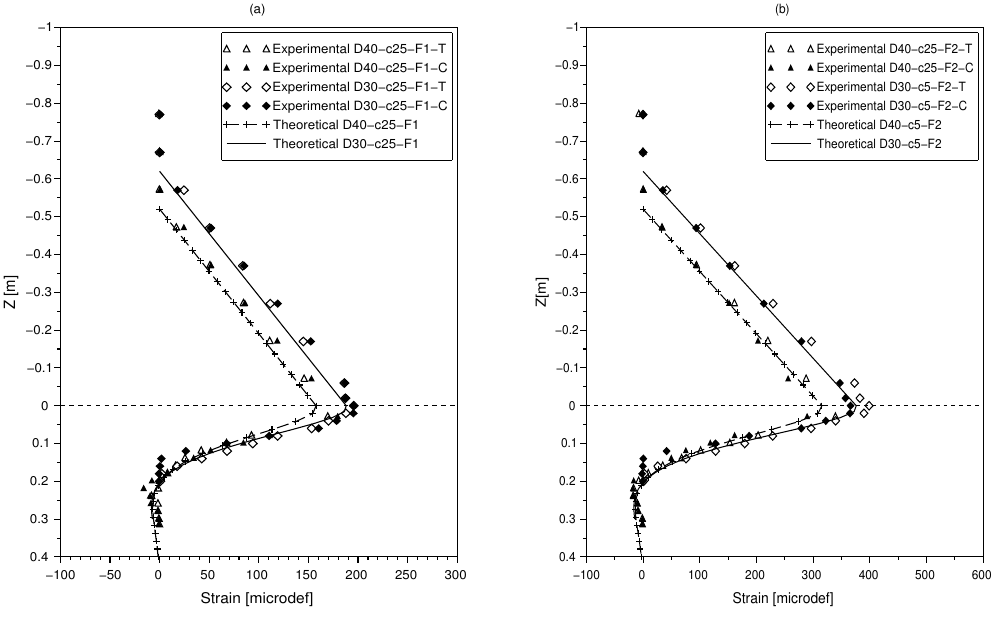
Figure 3. Strain profiles along the rod under tension ‘T’ and compression ‘C’ provided by the fiber optic for the load F [( a ) F = F 1 ( b ) F = F 2] applied at c = 25 cm from the tip of the rod for an embedded length of D = 40 cm and D = 30